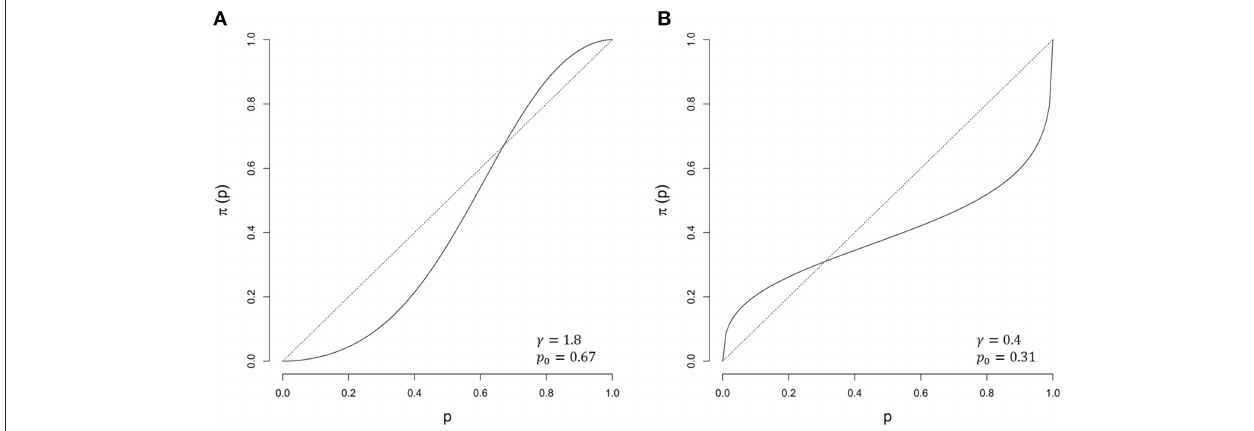
FIGURE 2 | Examples of probability weighting functions as proposed by Zhang and Maloney (2012). (A) γ = 1.8 and p 0 = 0.67 (solid) against the unweighted probabilities (dotted). (B) γ = 0.4 and p 0 = 0.31 (solid) against the unweighted probabilities